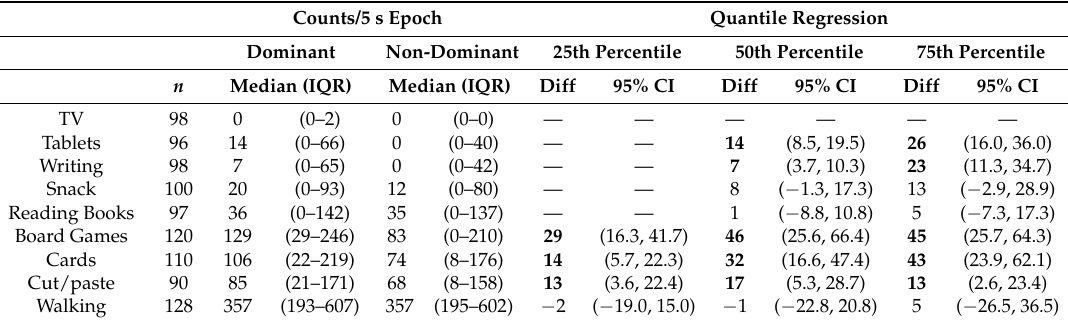
Table 2. Descriptive statistics and quantile regression results testing differences in counts produced by dominant and non-dominant wrist placement ( n = 167 unique children and 937 child